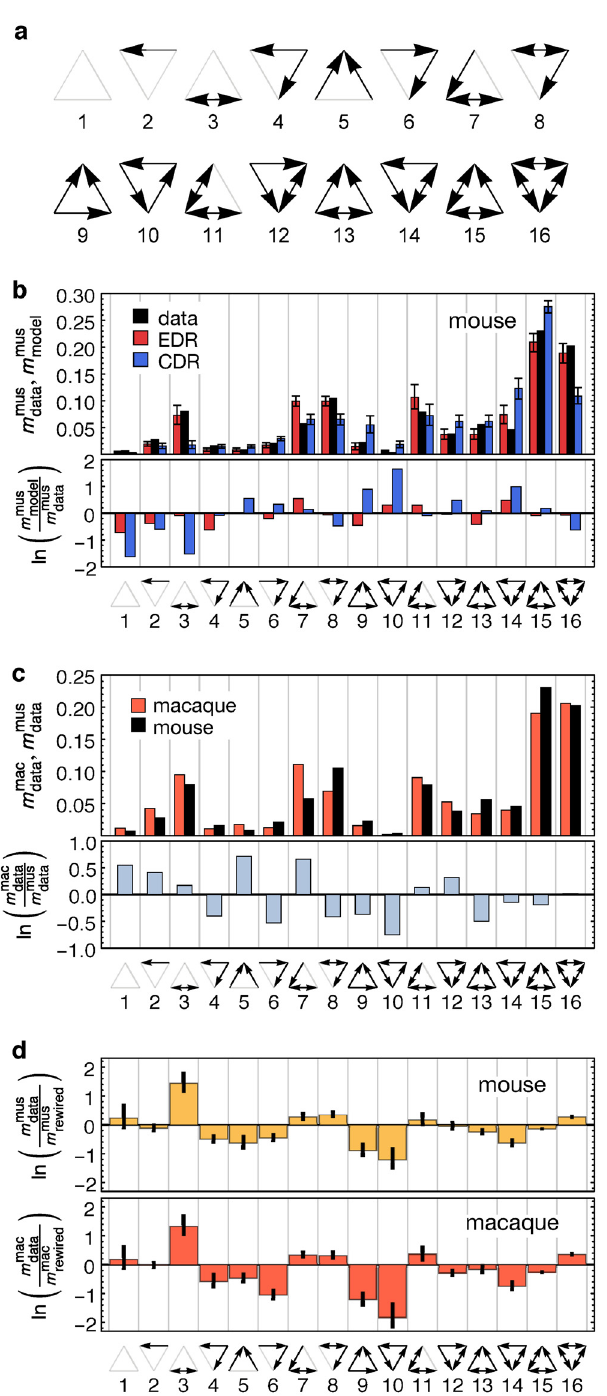
Fig 5. Three node motif profiles of mouse and macaque connectomes. (a) Full complement of three node motifs, i.e. all possible connectivity patterns found for three nodes (b) Mouse motif distribution, EDR ( λ = 0.78 mm − 1 ), CDR models and data comparison. Note that the EDR captures much better the motif frequencies than does the CDR. The average of 1,000 model networks is shown; error bars represent 95% confidence intervals. (c) Motif distributions of macaque and mouse, comparison. (d) Motif distributions of mouse and macaque connectomes compared to a null model (logarithmic residuals) obtained from random rewiring of edges while preserving the in- and out-degree sequence. The average of 1,000 rewired networks is shown; the error bars show 95% confidence intervals.